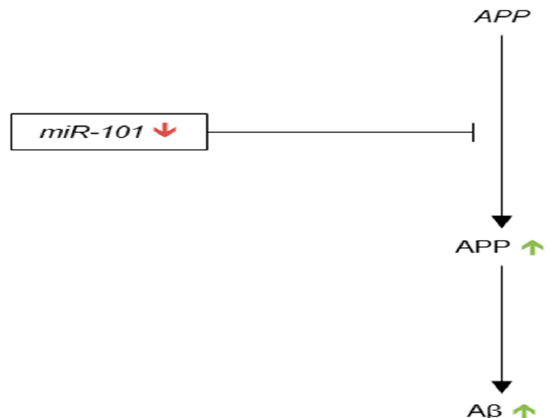
Figure 8. Regulation by miR ‐ 101. miR ‐ 101 inhibits the translation of APP. The red arrow indicates the significant downregulation of miR ‐ 101 expression observed in AD brain. The green arrows indicated the hypothetically increased levels of APP and A β resulting from the downregulation of miR ‐ 101.